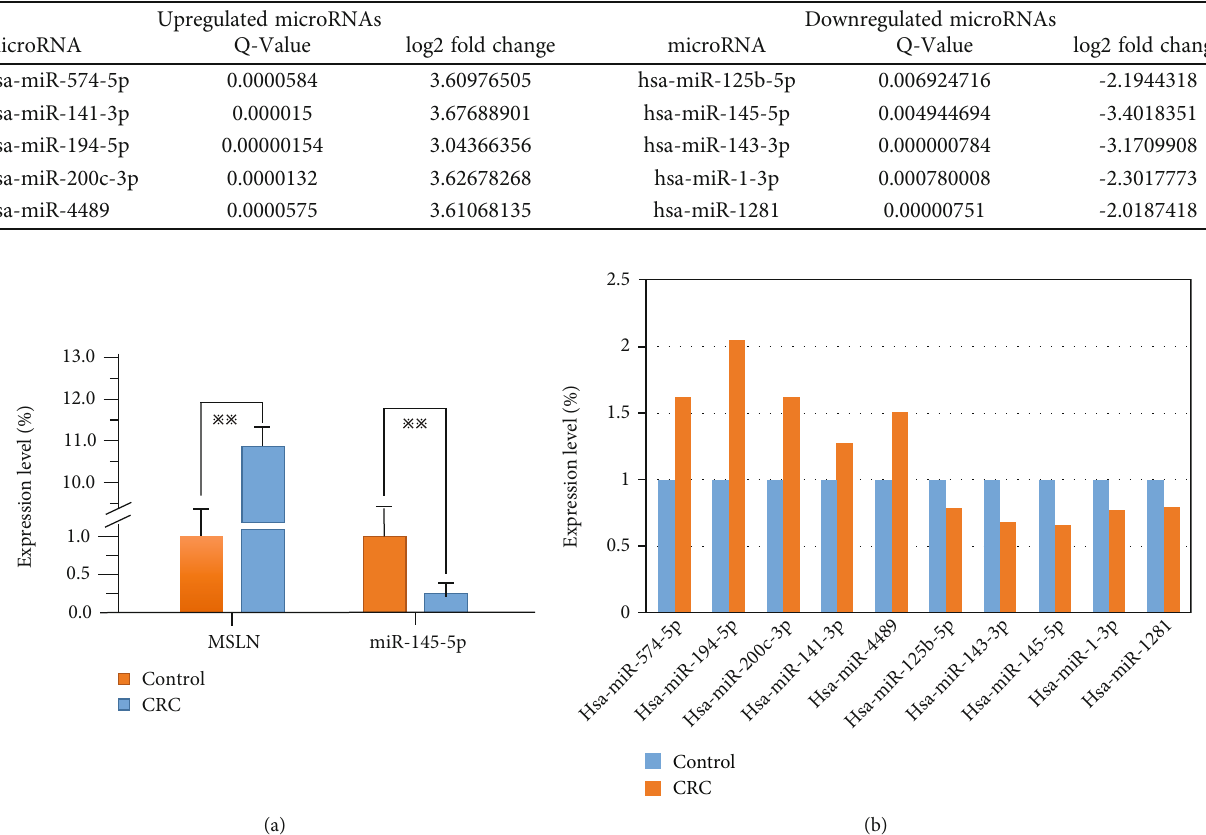
Table 2: Deregulated microRNAs in the inner tumor versus normal colorectal.